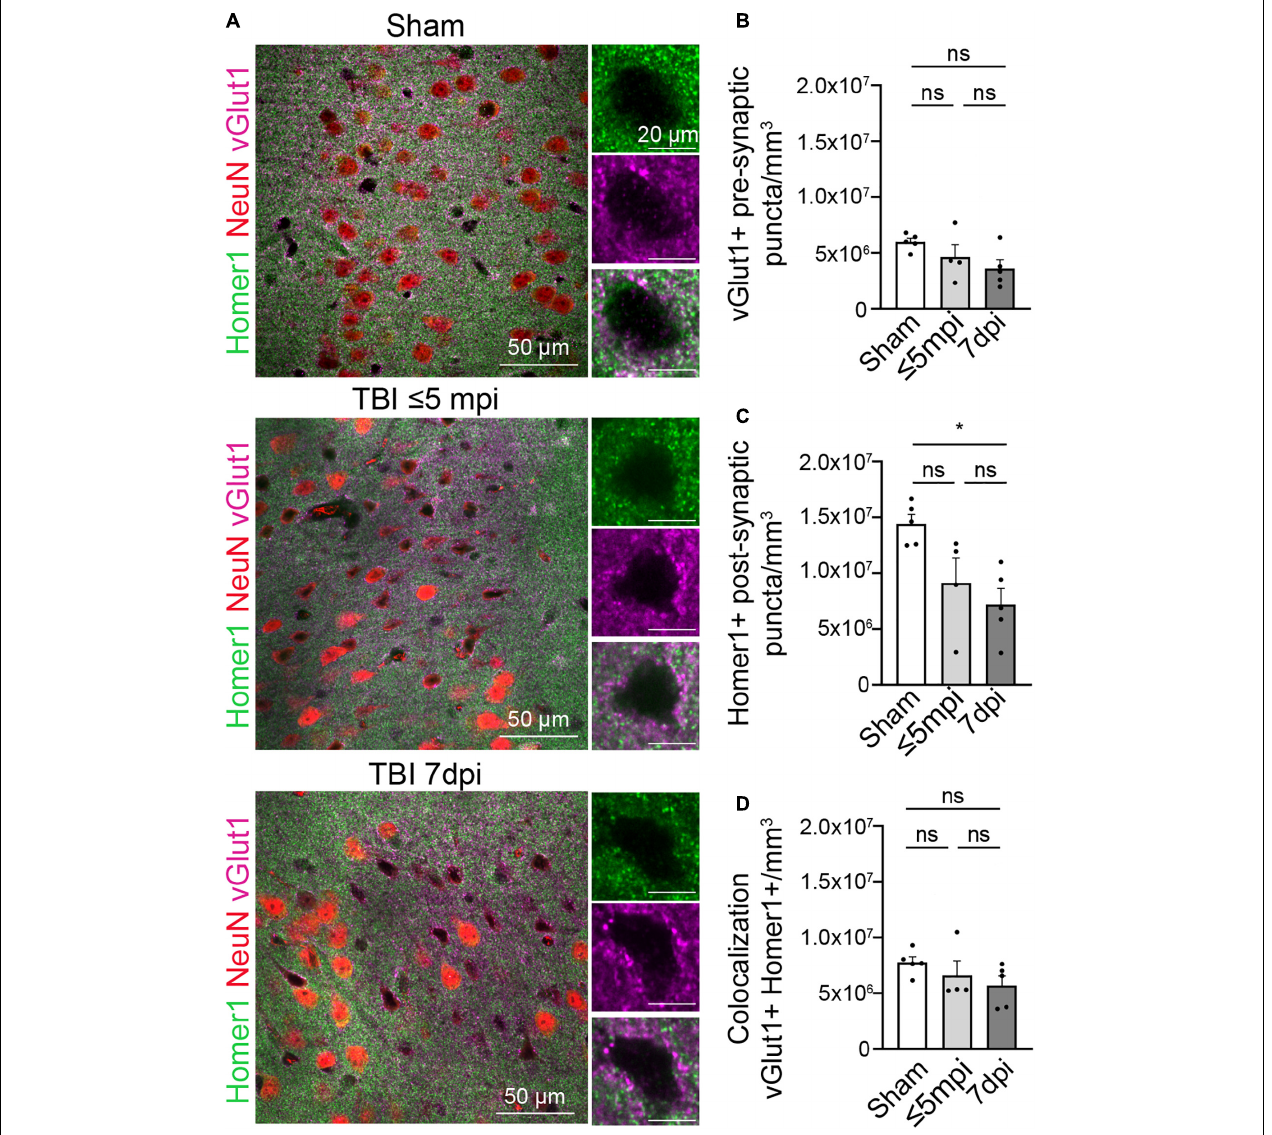
FIGURE 3 | Postsynaptic proteins are altered in atypical areas. (A) Neurons with atypical NeuN expression show a decrease in the postsynaptic Homer1 protein while the presynaptic protein vGlut1 expression remains constant. Each panel consisted of a large image of an area of interest and to the right side of the image shows 1 cell located in the area of interest. Panels on the top row show Sham, panel in the center row show TBI ≤ 5 min and panel on the bottom row show TBI 7 dpi (Magenta: vGlut1, Red: NeuN, Green: Homer1). (B) Number of vGlut1 puncta in a density of 3–5 cells (puncta/mm 3 ) was quantified and plotted per animal. There was no change in densities among all timepoints (Sham, 7,767,199 ± 500,109, n = 5; ≤ 5 min, 6,604,101 ± 1,297,827, n = 4; 7 dpi, 5,713,619 ± 843,873, n = 5). One-way ANOVA: non-significant, p -value = 0.2703. Post-hoc analysis (Tukey HSD): Sham vs. ≤ 5 min: p < 0.6422; Sham vs. 7 dpi: p < 0.2433; ≤ 5 min vs. 7 dpi: p < 0.7679. (C) Number of Home1 puncta in a density of 3–5 cells(puncta/mm 3 ) was quantified and plotted per animal. There was no significant change in densities between sham and ≤ 5 min, but there was a significant change between sham and 7 dpi. (Sham, 14,424,739 ± 835,170, n = 5; ≤ 5 min, 9,124,708 ± 2,214,359, n = 4; 7 dpi, 7,205,630 ± 1,414,819, n = 5) One-way ANOVA: significant, p -value = 0.0122. Post-hoc analysis (Tukey HSD): Sham vs. ≤ 5 min: p < 0.0742; Sham vs. 7 dpi: p < 0.05; ≤ 5 min vs. 7 dpi: p < 0.6554. (D) Number of colocalized puncta between homer1 and vGlut1 in a density of 3–5 cells (puncta/mm 3 ) was quantified and plotted per animal. There was no change in densities among all timepoints (Sham, 5,971,345 ± 324,190, n = 5; ≤ 5 min, 4,603,244 ± 1,127,077, n = 4; 7 dpi, 3,598,635 ± 758,416, n = 5). One-way ANOVA: non-significant, p -value = 0.1111. Post-hoc analysis (Tukey HSD): Sham vs. ≤ 5 min p < 0.4453; Sham vs. 7 dpi p < 0.0952; ≤ 5 min vs. 7 dpi p < 0.6367. * p -value ≤